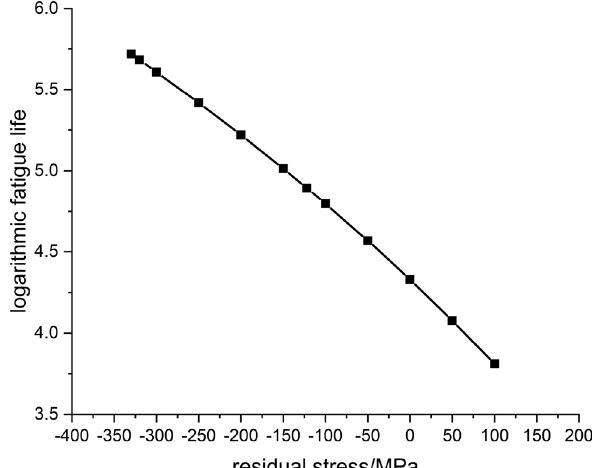
Figure 12: The curve of the logarithmic fatigue life versus the surface residual